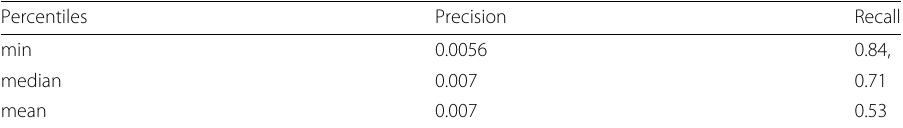
Table 9 Identified metabolites reachability from the private egocentric proteins networks according the combined score percentiles Percentiles Precision Recall